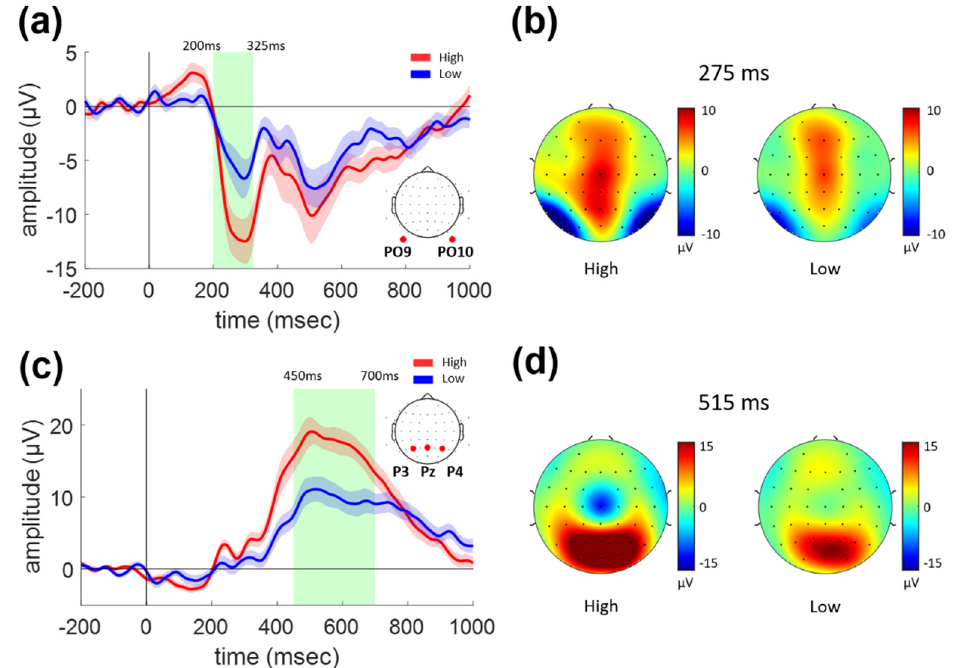
Figure 2. The grand-average ERP waveforms and topographical distributions for sudden stop task. ( a ) The grand-average ERP waveforms for PO9 and PO10 electrodes. ( b ) Topographical distributions of ERP at 275 ms. ( c ) The grand-average ERP waveforms for P3, Pz, and P4 electrodes. ( d ) Topographical distributions of ERP at 515 ms.